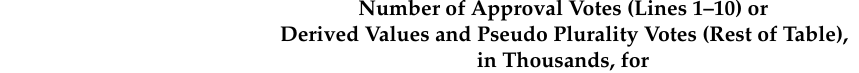
Table 6. Details for approval votes for South Dakota (2024 election, Scenario